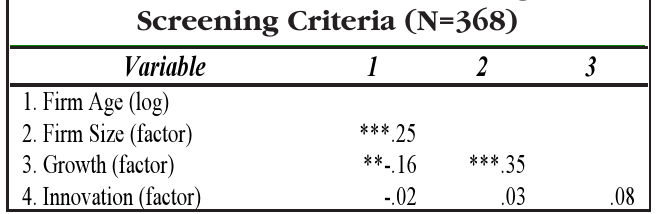
Table 3. Correlations Among Screening Criteria